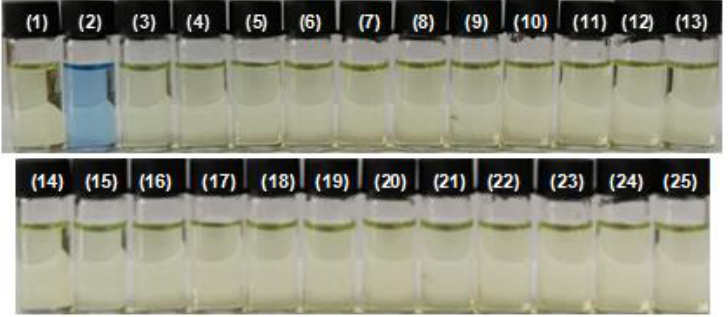
Figure 3. The color changes of L-ol (10 μM) towards various competitive species (50 μM) i n PBS aqueous buffer (DMF:PBS = 7:3, 20 mM, pH = 7.4). 1. Free L-ol , 2. HOCl, 3. Br – , 4. AcO – , 5. Cl – , 6. F – , 7.